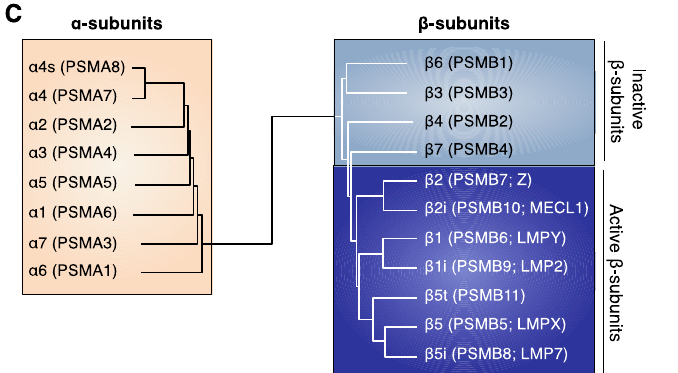
Figure 1. ( A ) Structure of the eukaryotic proteasome. The identical α -rings are each composed of seven distinct α -subunits ( α 1- α 7) (beige). The identical inner β -rings are each composed of seven distinct β -subunits ( β 1- β 7). Only three of the seven β -subunits are catalytically active, and these are β 1, β 2 and β 5 (dark blue). ( B ) Cross section of the 20S proteasome showing its internal cavities: the two antechambers of 59nm 3 and the central catalytic chamber of 84 nm 3 , where protein degradation takes place [9]. The length of the eukaryotic proteasome is about 150Å and its diameter is about 115Å [8]. The gate of the proteasome, which is delimited by the outer α -rings, has a pore size ranging from 9 to 13Å in its closed conformation and of 20Å in its open conformation [5,10]. ( C ) Relationship between the α - and β -subunits . Dendrogram showing the similarities between the eukaryotic α - subunits and between the eukaryotic β -subunits. The names of the proteasome subunits are mentioned following the common nomenclature ( α and β ). In parentheses we added the HUGO (human genome organization) nomenclature (PSMA and PSMB), as well as a previously common nomenclature for the catalytic subunits β 1 (LMPY), β 2 (Z), β 5 (LMPX), β 1i (LMP2), β 2i (MECL1) and β 5i (LMP7).